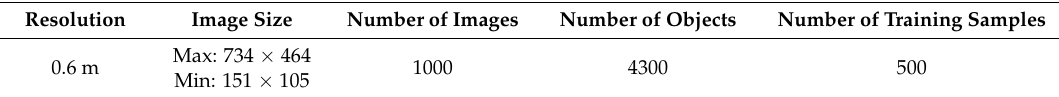
Table 2. Introduction of experimental data.